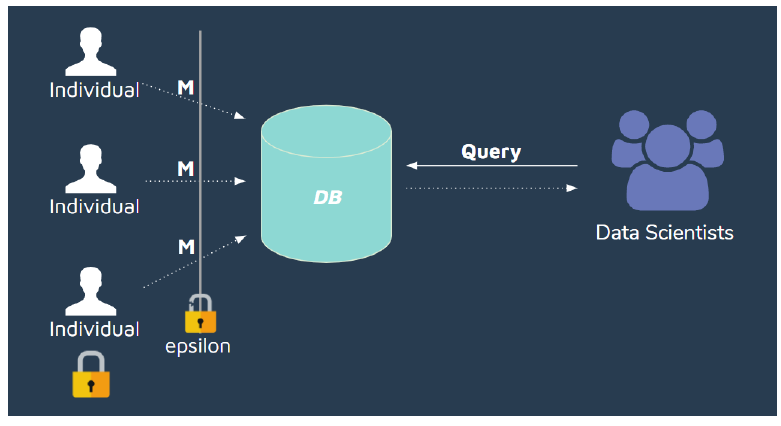
Figure 2. Local model.